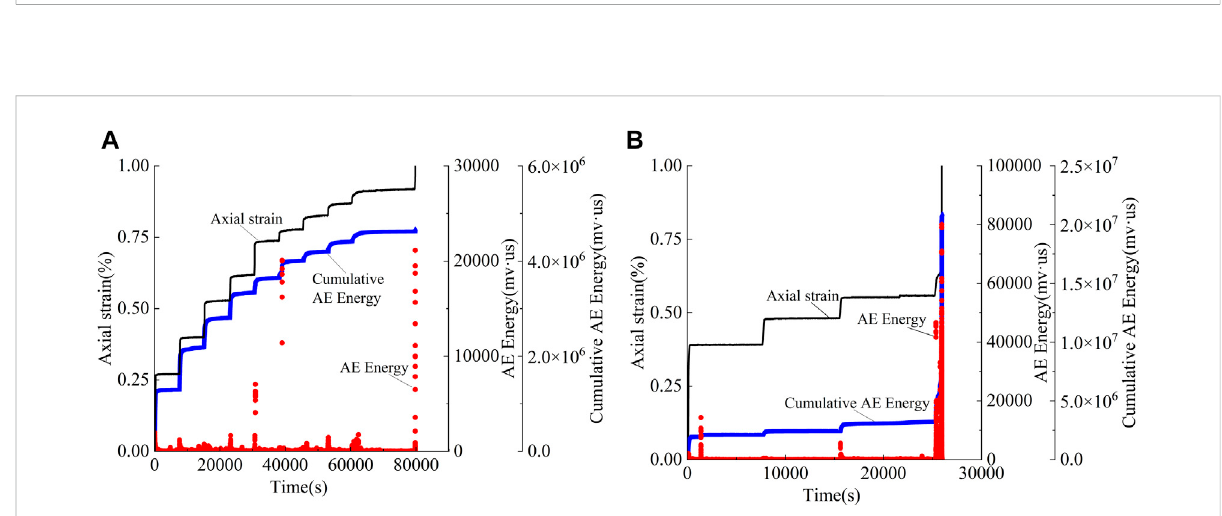
FIGURE 11 Axial strain-AE energy-cumulative AE energy-time curves of specimens. (A) Intact specimen. (B) Prefabricated fi ssures specimen.